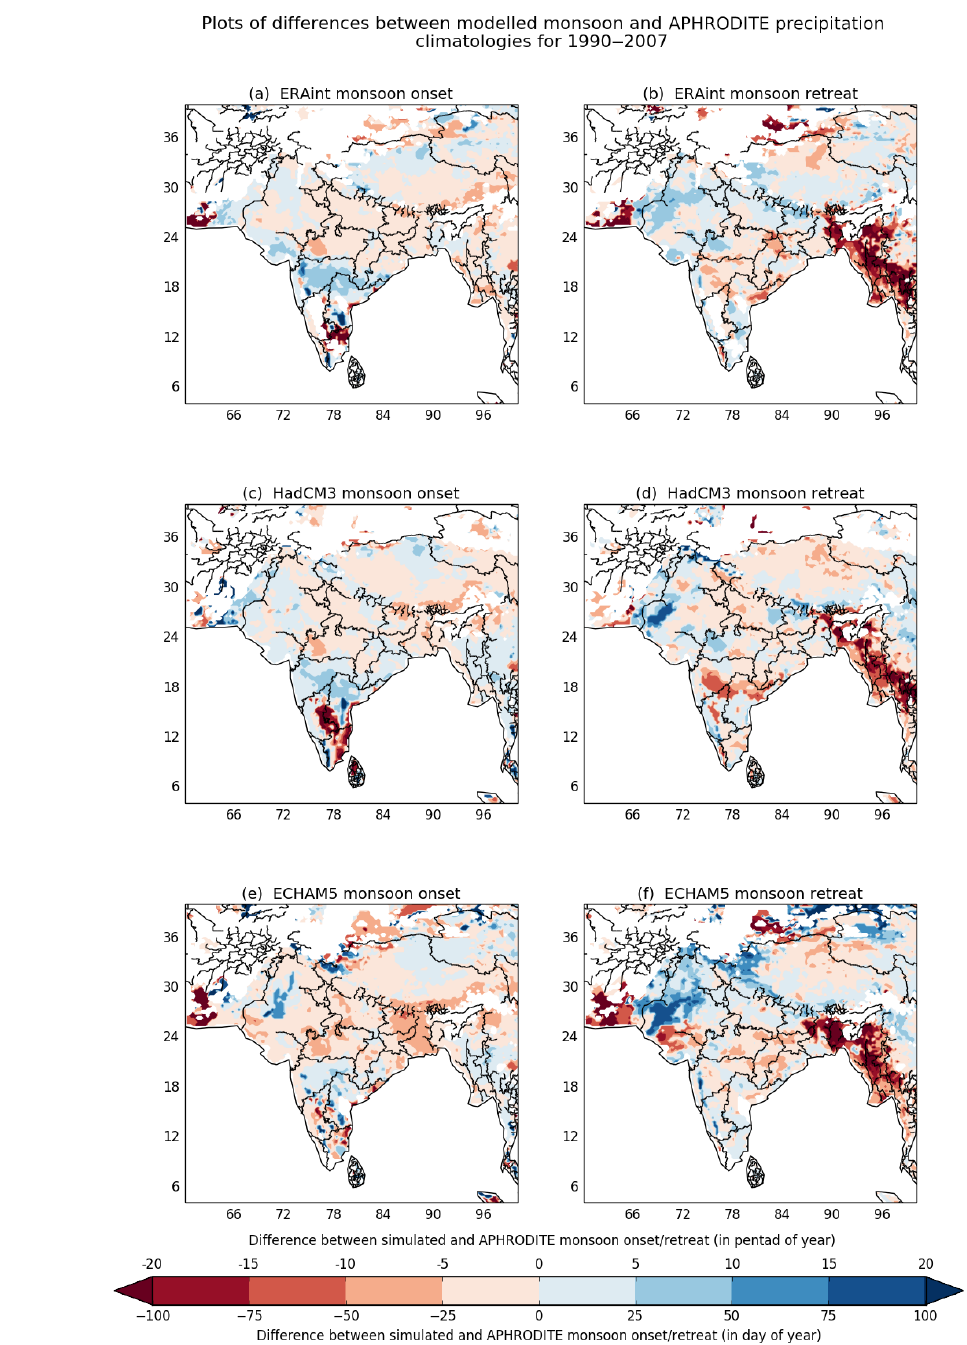
Figure 4. Plots of the 1990–2007 difference between model simulations and APHRODITE observations for the monsoon statistics; monsoon onset (a, c, e) and retreat (b, d, f) ; ERA-Interim ( a and b ), HadCM3 ( c and d ), and ECHAM5 ( e and f ) calculated using the NPPI